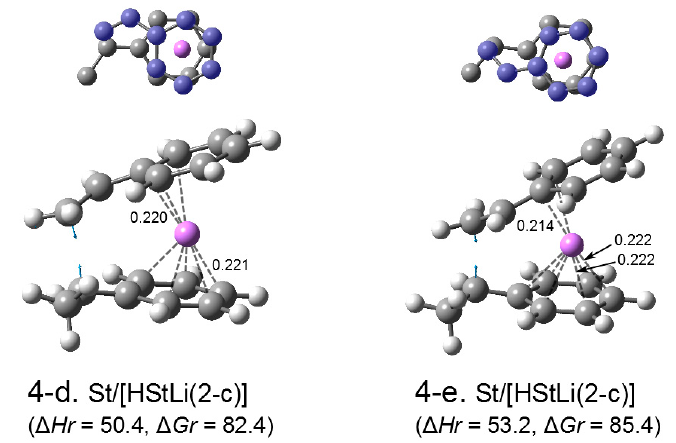
Figure 4-2. Transition states for the addition of styrene to HStLi(2-c) in the gas phase. ∆ Hr and ∆ Gr , the relative enthalpy and relative free energy, are expressed in kJ·mol –1 . Drawing details as in Figure 4-1.